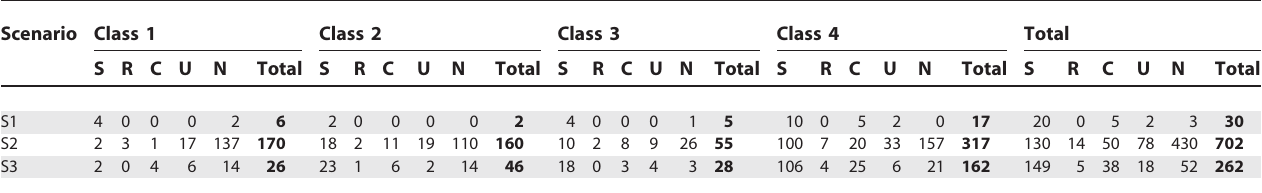
Table 2. Number of Sequence Pairs in Each Class Favoring a Particular Scenario Scenario Class